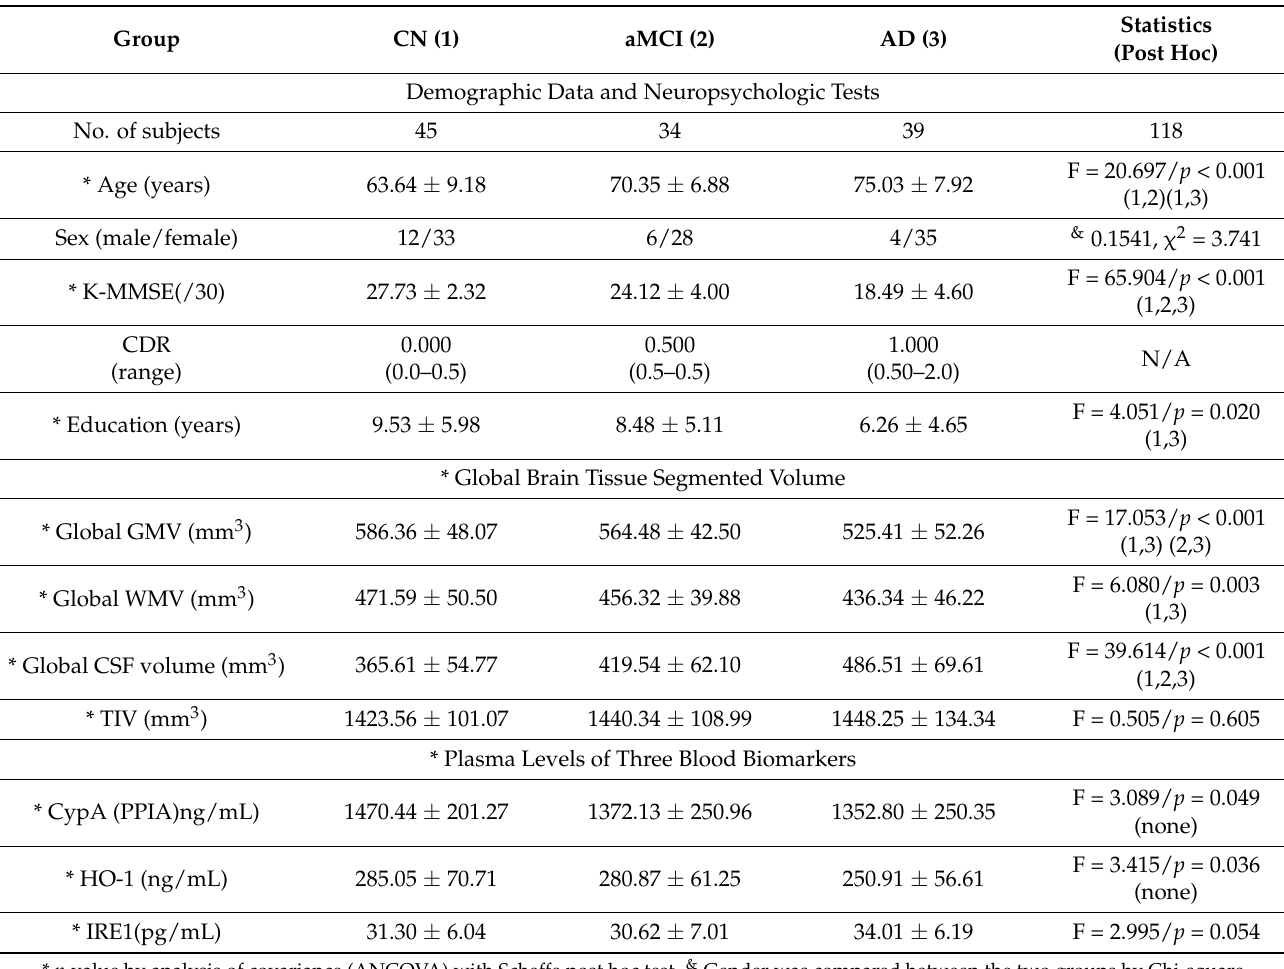
Table 1. Summary of demographic data, neuropsychological test results, global brain tissue volume, levels of the three blood-based biomarkers, and statistical